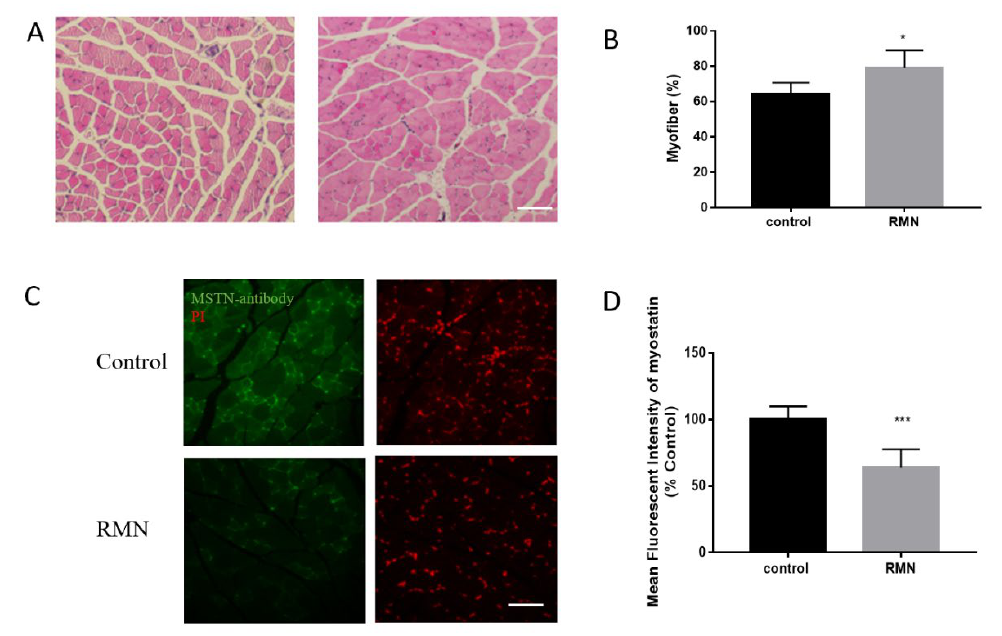
Figure 4. RMN increased muscle fiber and inhibited MSTN protein. ( A , B ) H&E staining showed the muscle fiber density of the mice injected with RMN were significantly increased. Scale bar: 100 µ m. ( C , D ) Tissue immunofluorescence analysis indicated that MSTN protein was expressed in the cytoplasm of the muscle of the mice. The expression of MSTN in the muscle tissue of the mice injected with RMN was distinctly decreased. Scale bar: 50 µ m. * p < 0.05; *** p < 0.001; statistical analysis was performed with Student’s t -test for comparison.